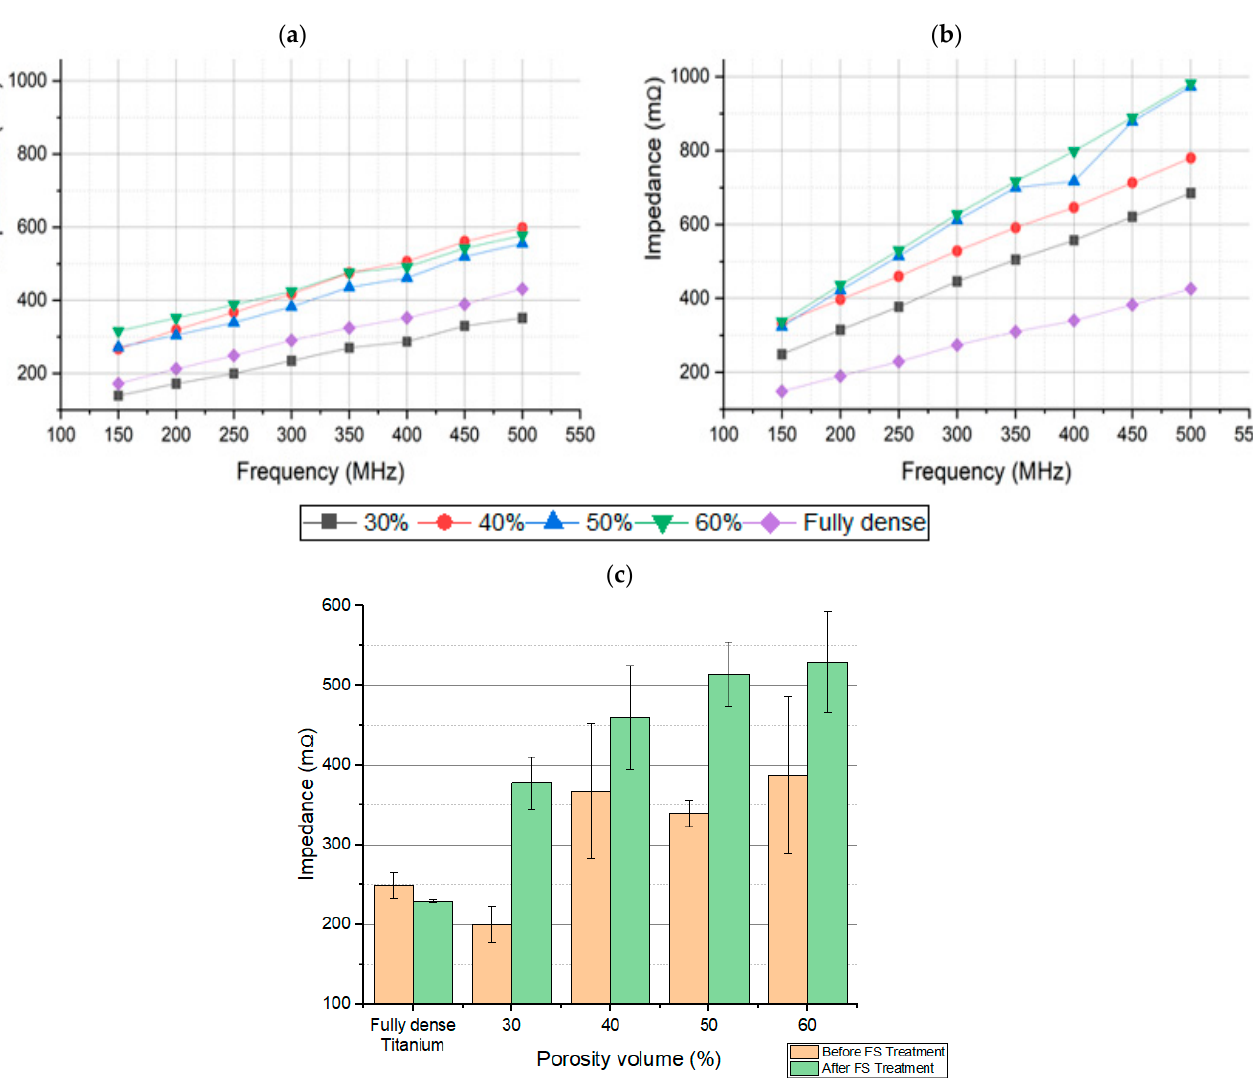
Figure 4. Impedance of the different samples with pore size 100–200 µm ( a ) before FS, And ( b ) after FS. The impedance values are directly proportional to the frequency, with higher sensitivities at higher frequencies. ( c ) Impedance values vs porosity volumes at 250 MHz. higher frequencies. ( c ) Impedance values vs porosity volumes at 250